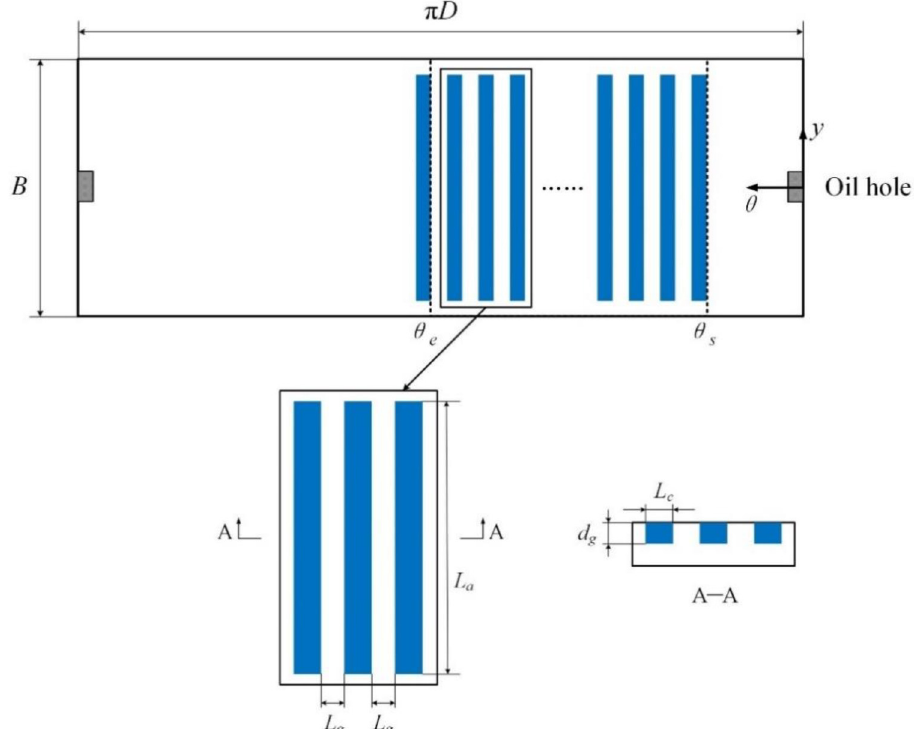
Fig. 2. Groove textures in bearing inner surface.